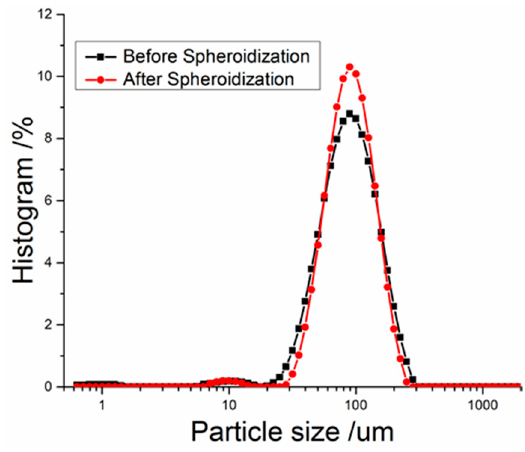
Figure 6. The size distribution of RDX before and after spheroidization. Table 6. The specific surface area of RDX before and after spheroidization Experiment